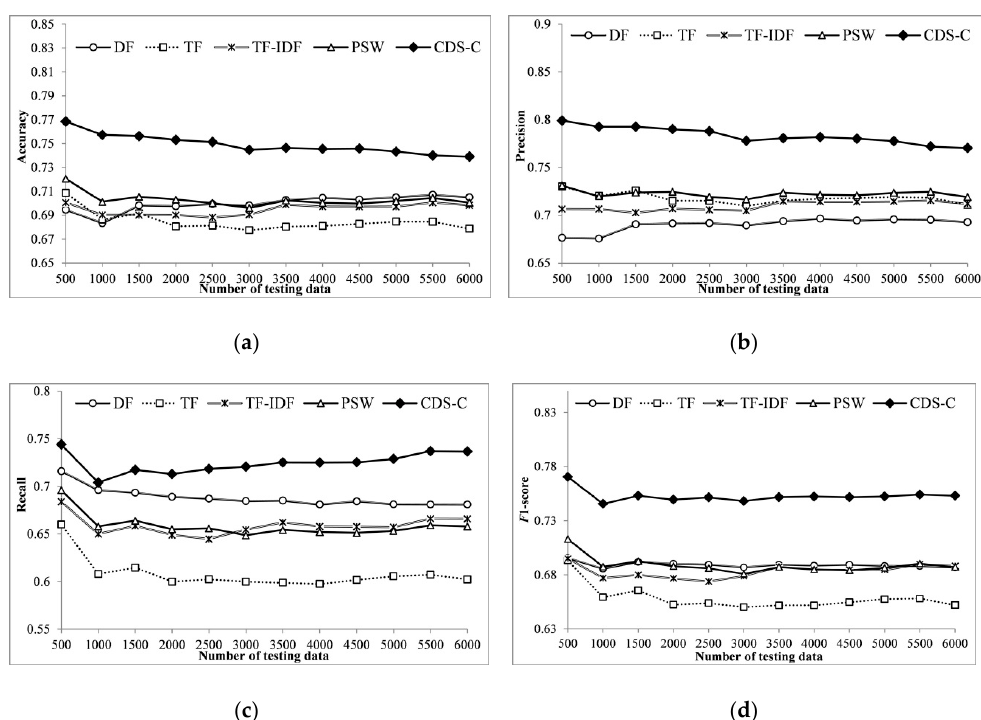
Figure 4. The comparisons of the schemes on various metrics. ( a ) accuracy; ( b ) precision; ( c ) recall; ( d ) F1-score.